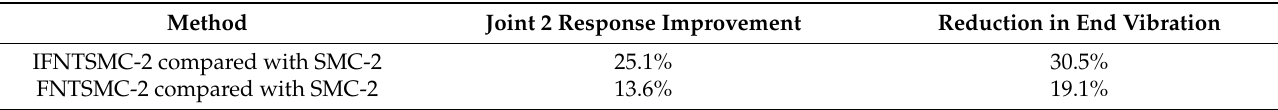
Figure 10. End deformation in the experiment. Table 4. Comparison of control methods.